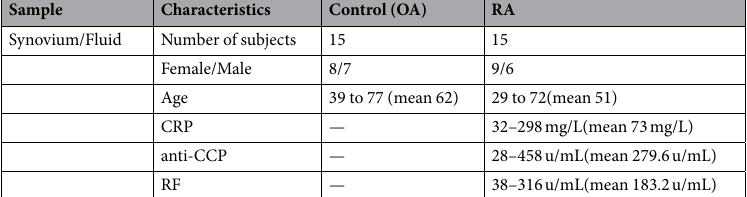
Table 1. Demographic characteristic of studied